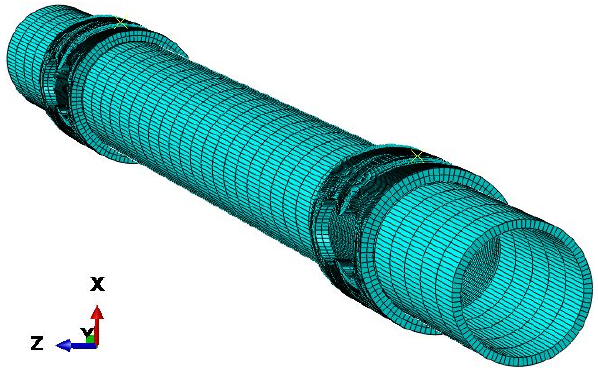
Figure 2. Axle meshed for simulations (front in Z direction).